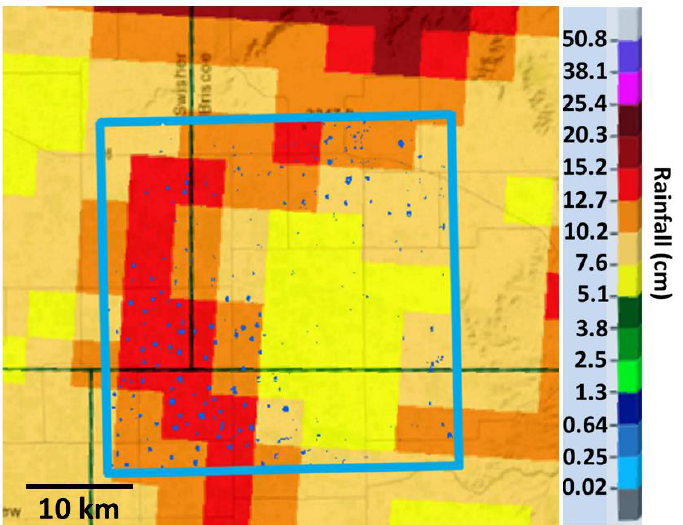
Figure 4. Playa lake surface area and radar-estimated precipitation for the 30 × 30 km square region shown in Figure 1a (and delineated here by the blue square). Playa water surface area for 9 July 2021 within the blue square is denoted in blue and calculated using the QGIS Semi-Automatic Classification Plugin [16,21]. The underlying map of radar-estimated rainfall between 15 June and 14 July 2021 is courtesy of the National Weather Service Advanced Hydrological Prediction Service https://water.weather.gov/precip/ (accessed on 15 March 2022).